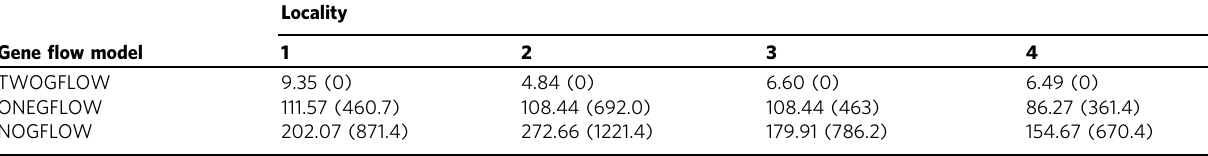
Fastsimcoal2 comparisons between models for independent SNP datasets for each locality. Differences in likelihood between observed and simulated site (allele) frequency spectra are given for all modelsand localities.Values inparenthesesprovide Δ AICunitsbetween eachmodeland thebest model(i.e., TWOGFLOWat alllocalities).Probabilitieswithrespect tonodifferencein minimizationof information loss are not provided because even for the smallest Δ AIC between models (i.e., 361.4 for ONEGFLOW at locality 4) the probability for ONEGFLOW relative to TWOGFLOW is extremely small (1.1×10 − 157 ). Sample sizes for localities 1 – 4 were: 17, 17, 20, and 17, respectively.